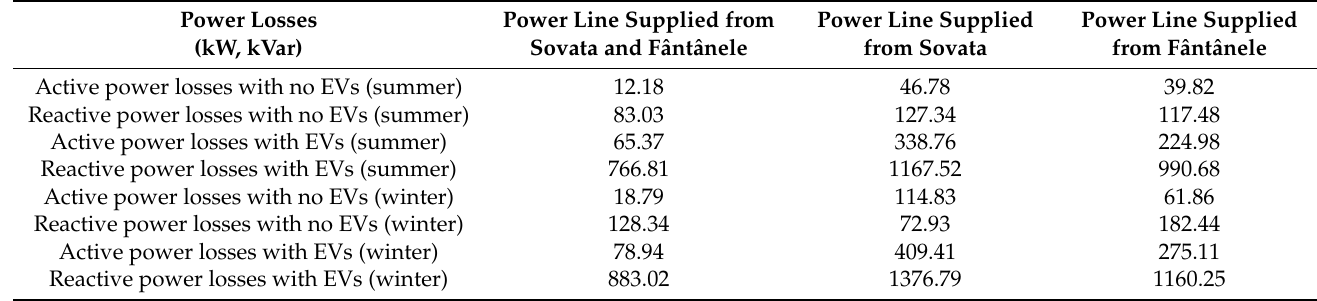
Table 8. Power losses at 2:00 (scenario 1).